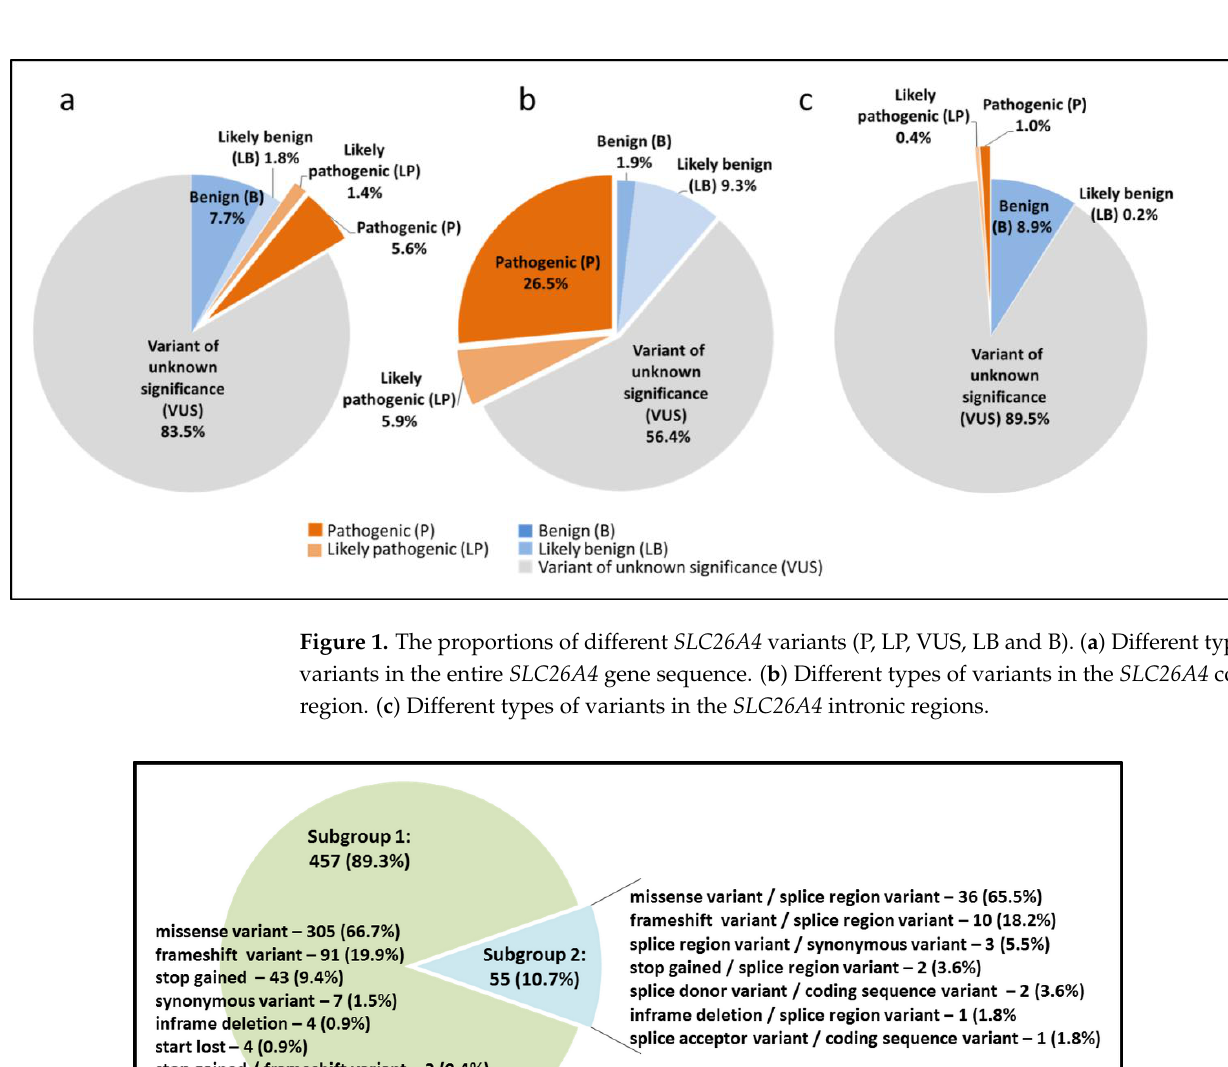
Figure 1. The proportions of different SLC26A4 variants (P, LP, VUS, LB and B). ( a ) Different types of variants in the entire SLC26A4 gene sequence. ( b ) Different types of variants in the SLC26A4 coding region. ( c ) Different types of variants in the SLC26A4 intronic regions.